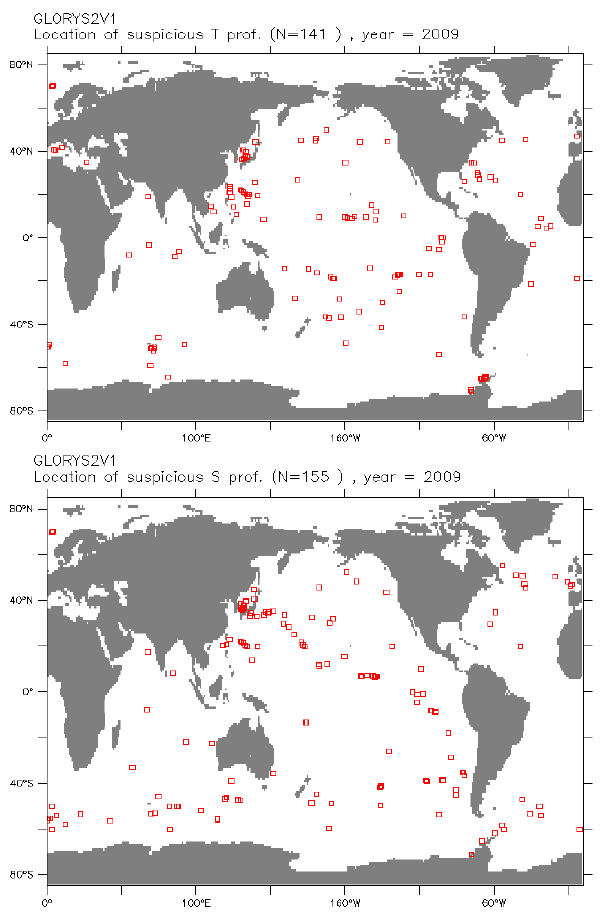
Fig. 9. Geographical location of suspicious temperature (top) and salinity (bottom) profiles diagnosed in 2009 with GLORYS2V1 quality